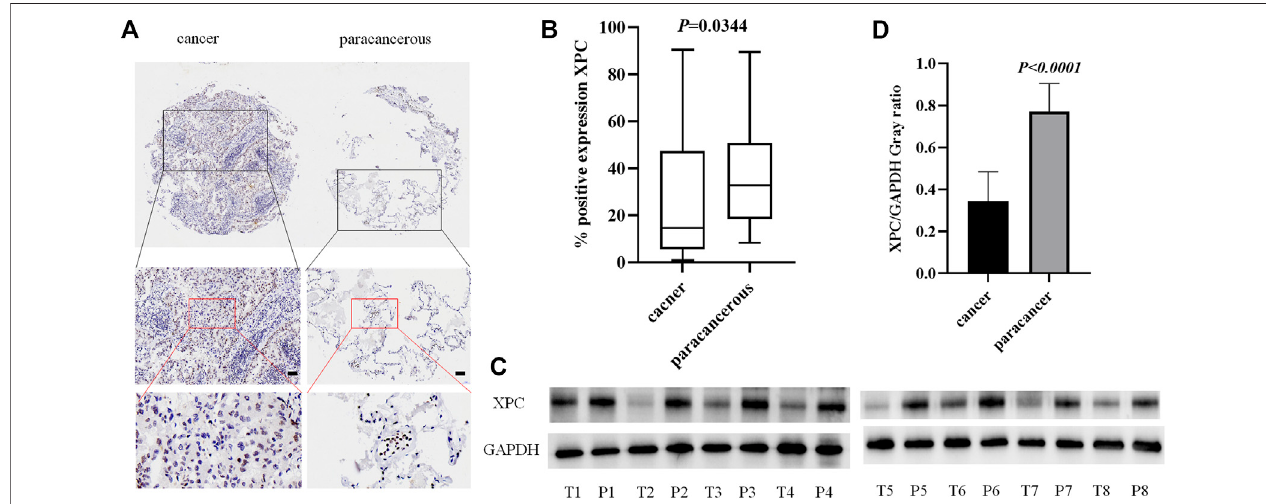
FIGURE1| TheexpressionofXPCinlungadenocarcinomacancertissueandparacanceroustissue. (A) .IHCdetectionofXPCexpressioninlungadenocarcinoma cancertissueandparacanceroustissue.BrownmeansXPCpositivereaction,XPCisexpressed inthenucleus, andblueisnuclearstaining.Allbar inthe fi gure (cid:1) 50 μ m. (B) . GraphPad Primes 8 statistics found that XPC expression is higher in paracancerous tissue than in cancer tissue ( p (cid:1) 0.0344). (C) . T is cancer tissue, P is paracancerous tissue. Western blot detects the expression of XPC in the fresh cancer tissue and paracancerous tissue of 8 lung adenocarcinoma patients. (D) . Western blot counts the expression of XPC in fresh cancer tissue and paracancerous tissue of 8 lung adenocarcinoma patients, and the expression in paracancerous tissue is higher than that in cancer tissue ( p < 0.0001). Bars represent the means ± SD of 8 lung adenocarcinoma patients.